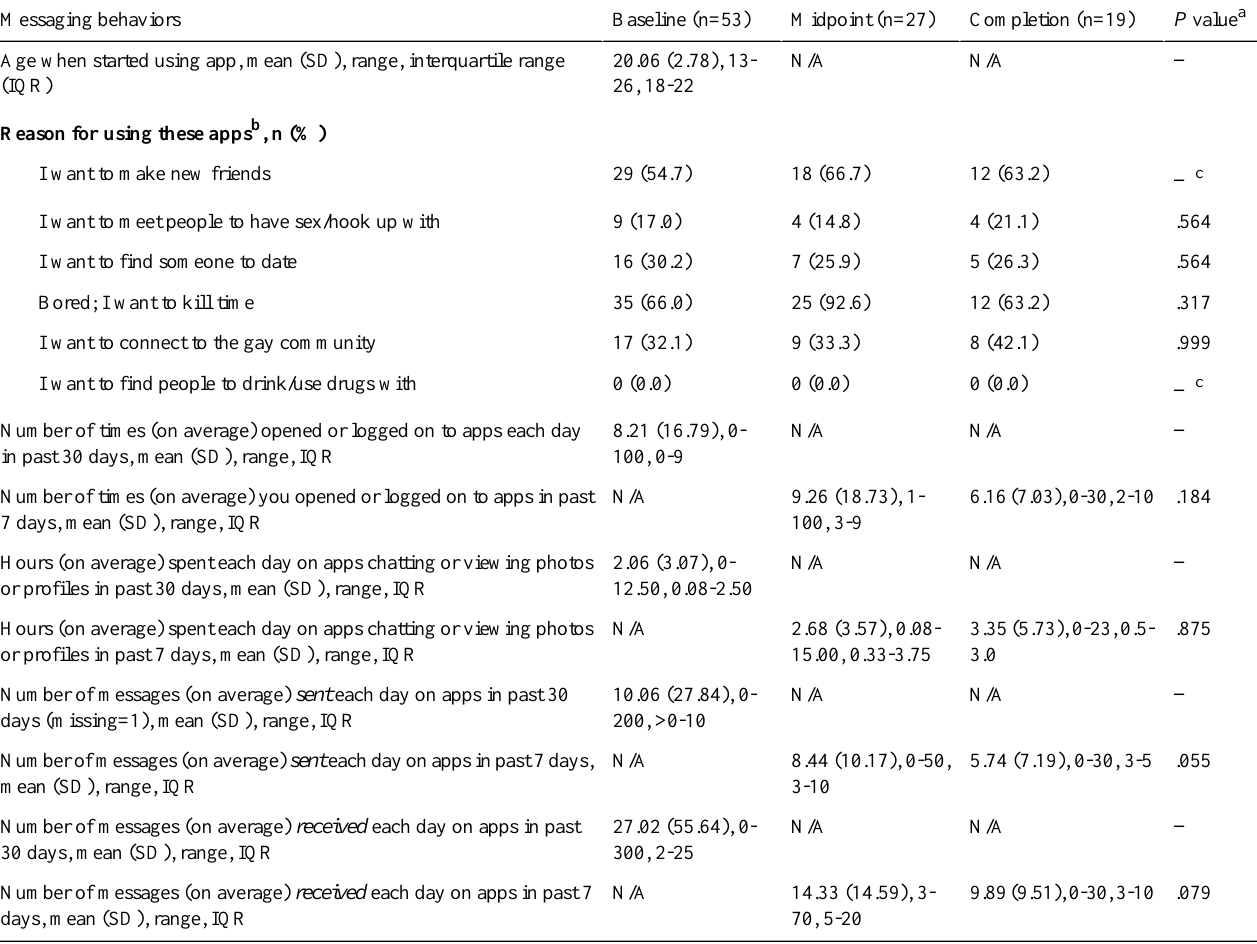
Table 3. Messaging behaviors across three time periods among app-using men who have sex with men.